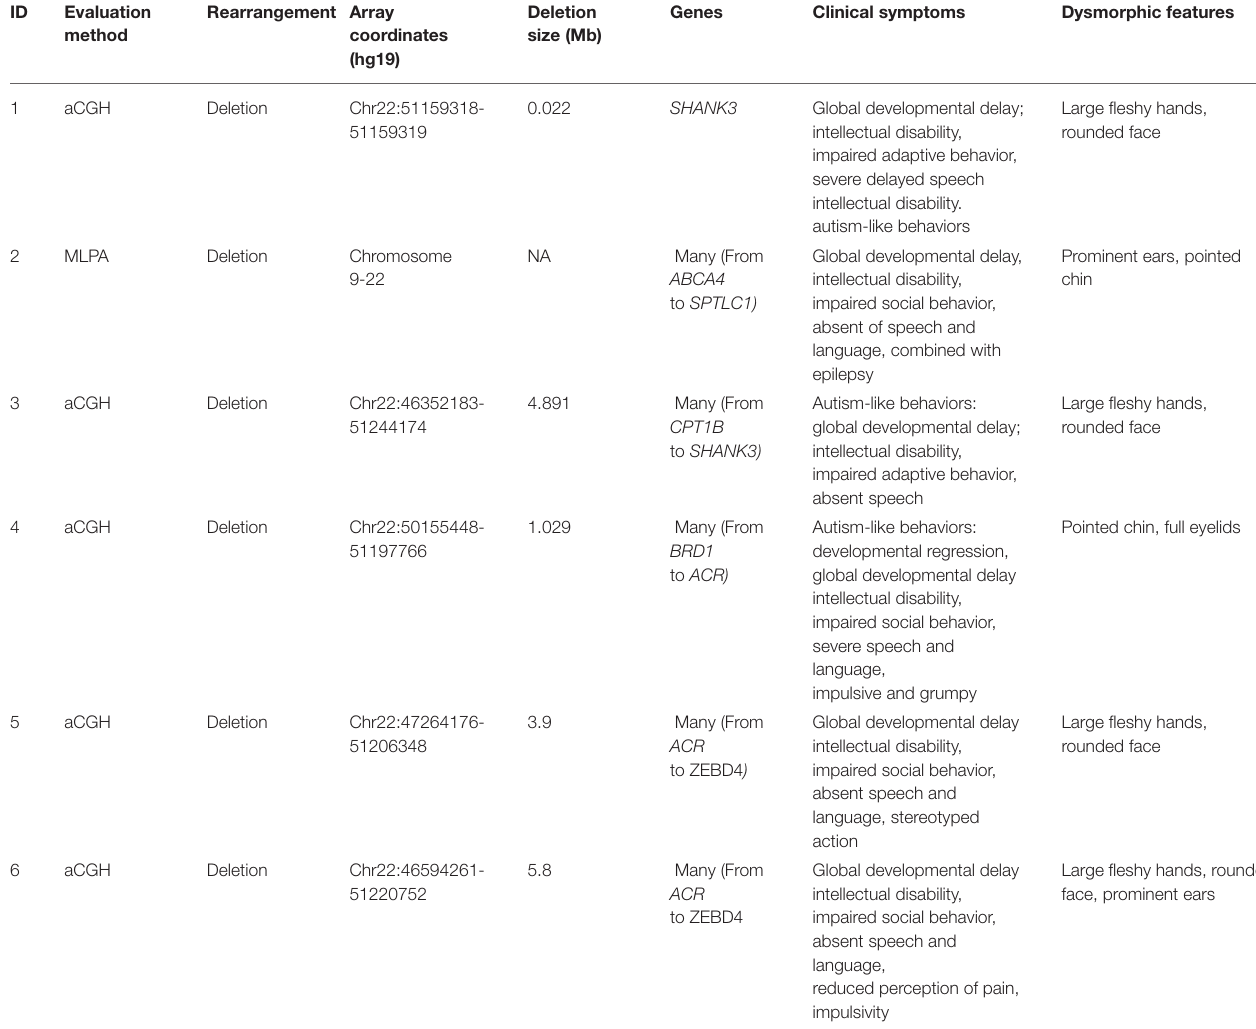
TABLE 2 | Details of the 22q13.3 deletions identified in 6 individuals with